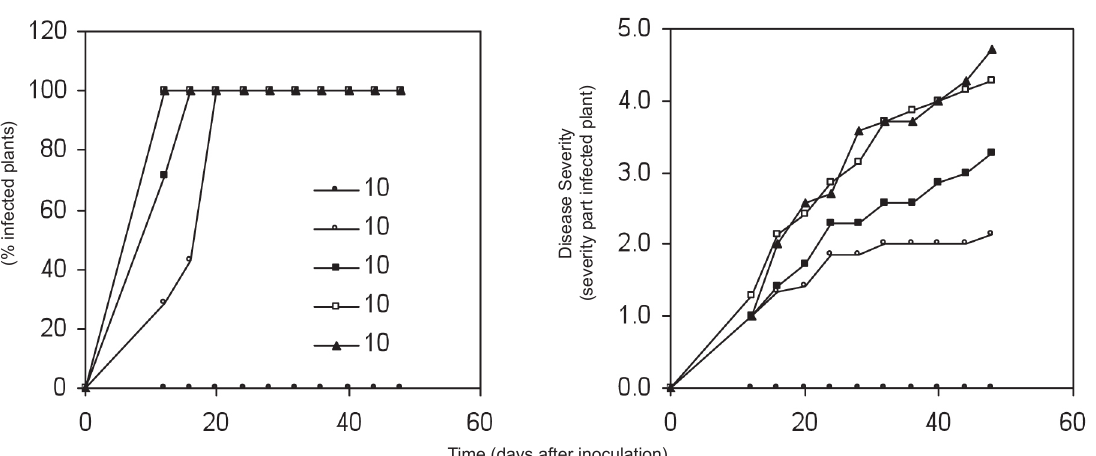
Figure 3. Incidence (a) and severity (b) of coriander blight on coriander plants spray-inoculated with Pseudomonas syringae pv. c oriandricola in nutrient broth at concentrations of 0 (control), 10 1 , 10 3 , 10 5 , and 10 7 CFU mL -1 .